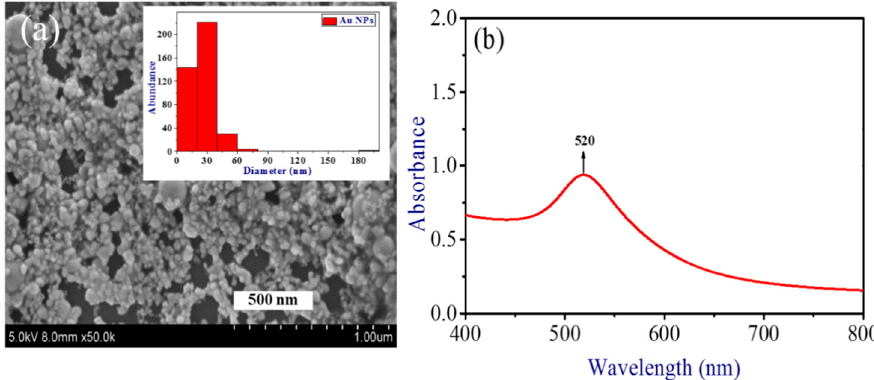
Figure 2. ( a ) SEM image and size distribution of Au NPs. ( b ) Absorption spectrum of Au NP thin